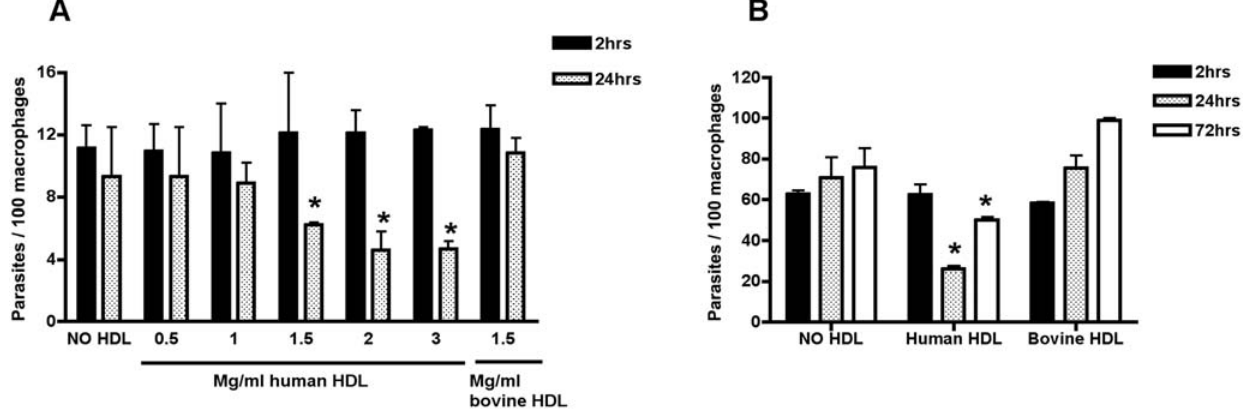
Figure 4. L.major and L.amazonensis are sensitive to lytic HDL within macrophages. Macrophages from Swiss-Webster intra-peritoneal cavities were infected with L. major metacyclics (A). BALB/c bone-marrow macrophages were infected with L. amazonensis promastigotes (B). The multiplicity of infection is 3:1; parasites were incubated with macrophages for 2 hours, before the addition of human or bovine HDL at 1.5 mg/ml or at the indicated concentrations. Infected macrophages were co-incubated for 2, 24, or 72 hours. The data represent the mean 6 standard deviation (SD) of duplicate cultures of one typical experiment that has been repeated twice. * p , 0.05 compared to bovine HDL at equivalent time points, ANOVA test.